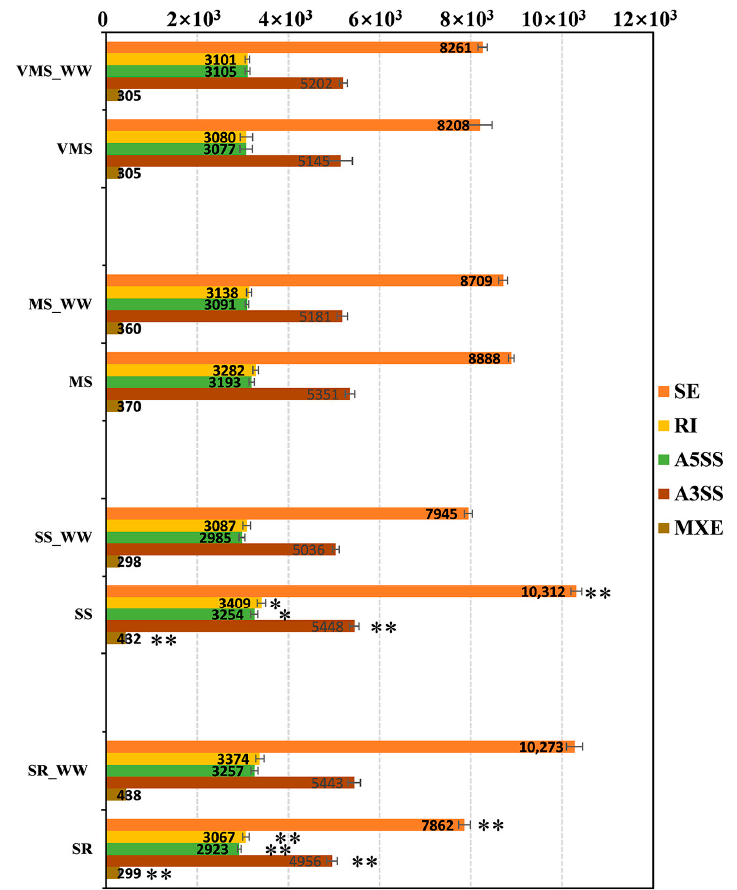
Figure 1. Categories and numbers of different types of alternative splicing (AS) events identified in